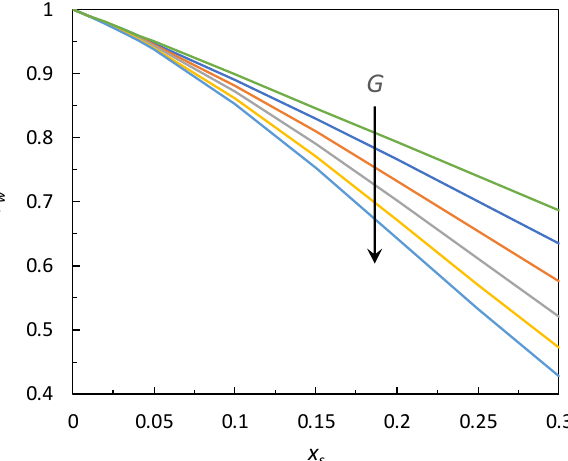
Figure 5. Effect of the global information index ( G = 10, 50, 100, 150, 200, 250, in the direction indicated by the arrow) on water activity curves.